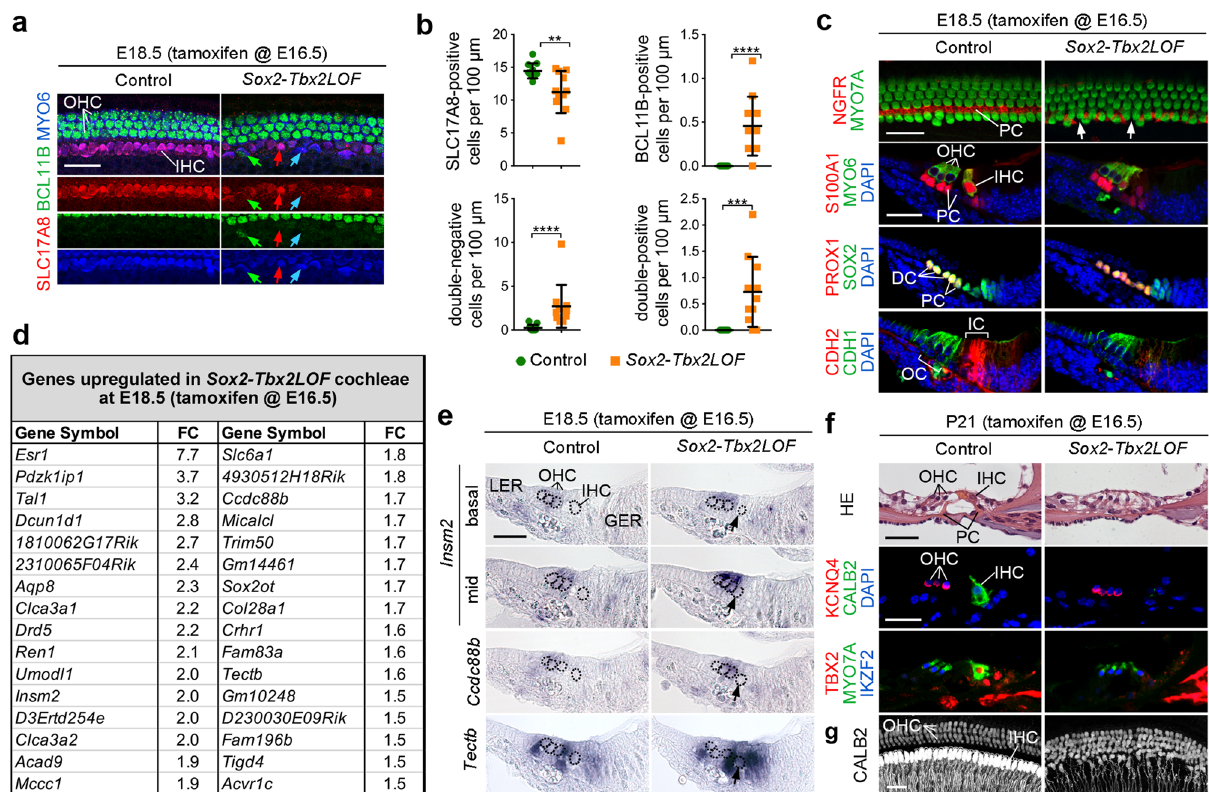
Fig.4| Tbx2 maintainsIHCandISCfatebypreventingtransdifferentiationinto OHCsandOSCs,respectively.a – d Hairandsupportingcelldifferentiationinmice in which Tbx2 was ablated ( Sox2-Tbx2LOF ) in SOX2 + cells in the organ of Corti by tamoxifen administration at E16.5. a , b (Co-)immuno fl uorescence analysis of IHC and OHC differentiation in E18.5 whole cochleae by antibodies against MYO6 (all haircells),BCL11B(OHCs),SLC17A8(IHCs).RedarrowpointstoaMYO6 + /SLC17A8 + IHC,greenarrowtoaMYO6 + /BCL11B + OHC-likeandbluearrowtoadouble-negative hair cell (SLC17A8 - /BCL11B - ) in the innermost hair cell row ( a ). b Quanti fi cation of hair cell types in the inner compartment. Mean±standard deviation, two-sided unpaired t-test with Welch ’ s correction or Mann-Whitney-U test. ** p <0.01;